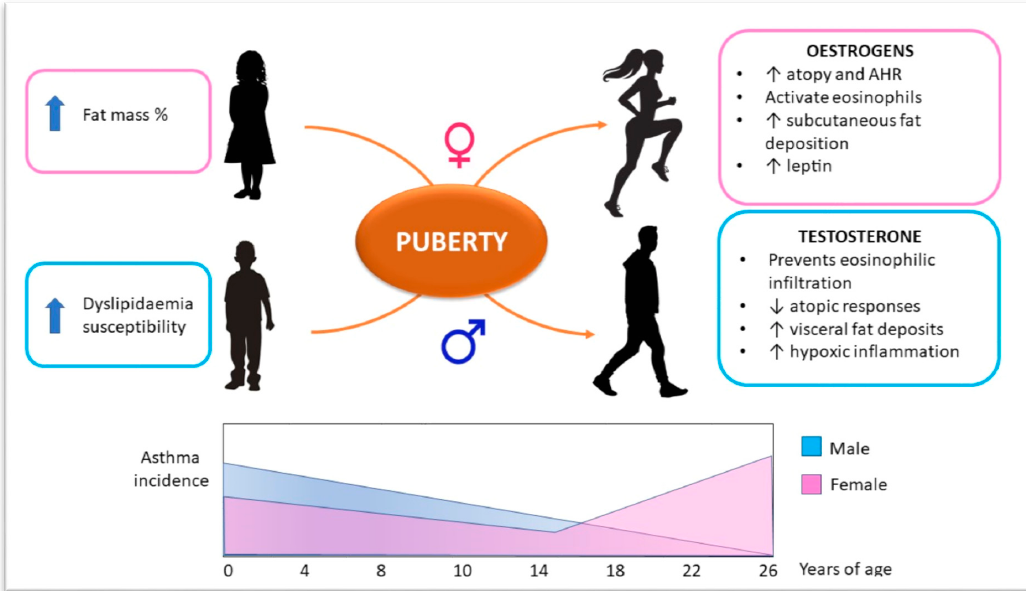
Figure 2. Sex hormones influence on the obesity–asthma link in children. Before puberty, asthma incidence is higher in males. Sex hormone production leads towards a shift in incidence ratio between genders. Estrogen effects are summarized in the right-hand pink box. Testosterone effects are summarized in the right-hand blue box. The diagram on the button schematically shows asthma incidence ratio in males and females from birth to early adulthood. AHR: airway hyperreactivity.